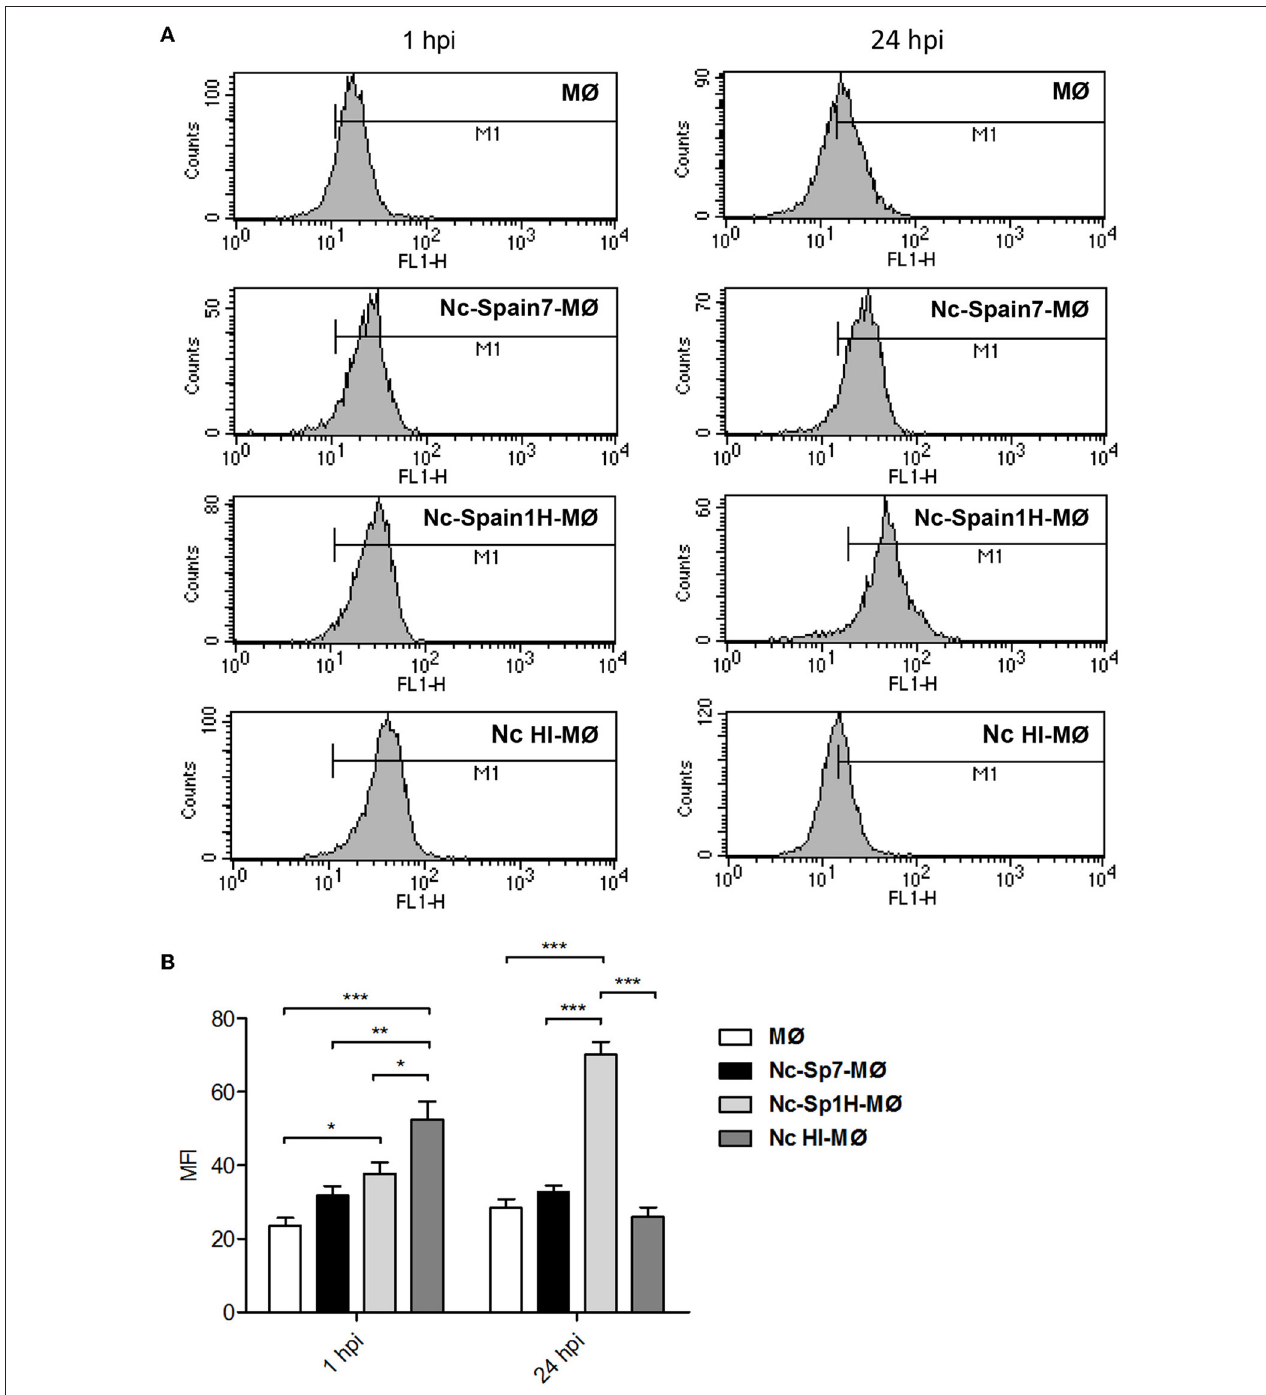
FIGURE 6 | ROS generation induced by N. caninum infection. (A) Representative histograms show the mean fluorescence intensity (MFI) determined by flow cytometry analysis of non-infected MØs (MØ), MØs challenged for 1 and 24h with N. caninum Nc-Spain7 (Nc-Spain7-MØ), Nc-Spain1H (Nc-Spain1H-MØ), and heat-inactivated tachyzoites (Nc HI-MØ) stained with CellROX Green Reagent. (B) The bar graph show the comparison of the MFI between groups. Each column and error bar represents the mean and SD of three replicates from three independent experiments; Significant differences are indicated (* p < 0.05; ** p < 0.01; *** p <